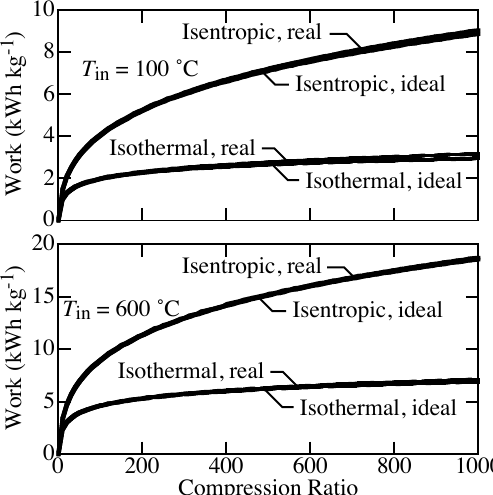
Figure 5. Comparison of isothermal and isentropic compression from 1 to 1000 bar at inlet temperature of 100 and 600 ◦ C. The fitting parameters used for the Helmholtz EOS are valid for temperatures below 727 ◦ C [41].